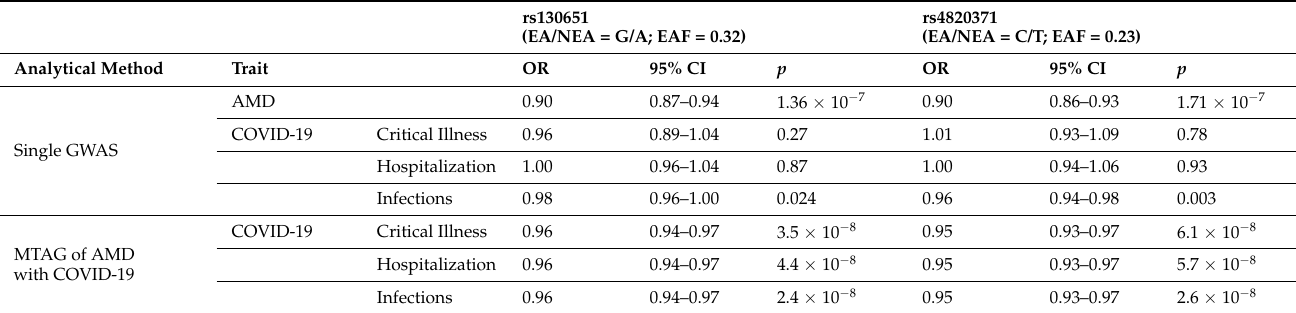
Table 1. Genome-wide significant associations in the PDGFB locus identified in the MTAG analysis of AMD with three COVID-19 outcomes (critical illness, hospitalization, and infections). Rs130651 and rs4820371 are in a moderate linkage disequilibrium (LD) in the European population of 1000 genome reference (r 2 =